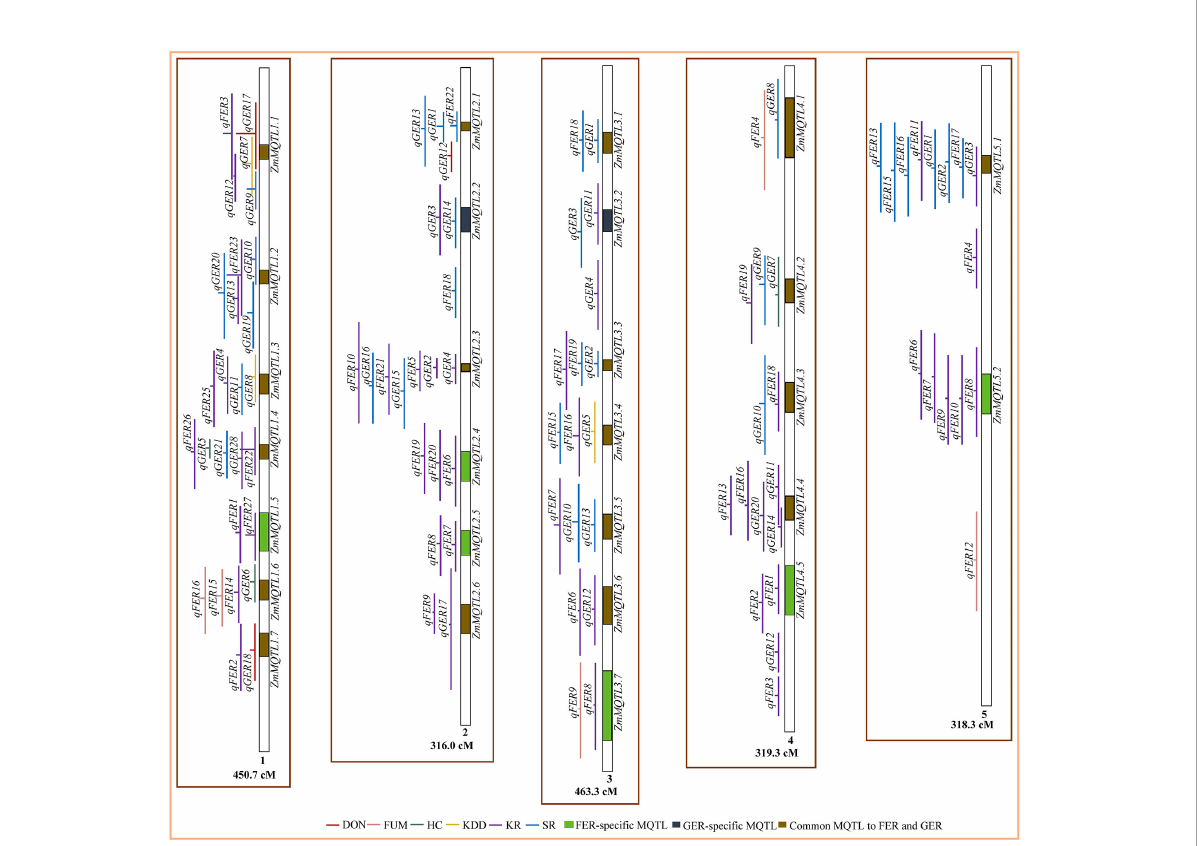
FIGURE 2 Colocalization of QTL for Fusarium ear rot (FER) and Gibberella ear rot (GER) and identi fi cation of meta-QTL (MQTL) on chromosomes 1 ‒ 5. The line in the middle of each QTL represents its LOD score in the original work. The longer this line, the higher the LOD score of the respective QTL. DON, deoxynivalenol accumulation; FUM, fumonisin accumulation; HC, husk coverage; KDD, kernel dry-down rate; KR, kernel resistance; SR, silk